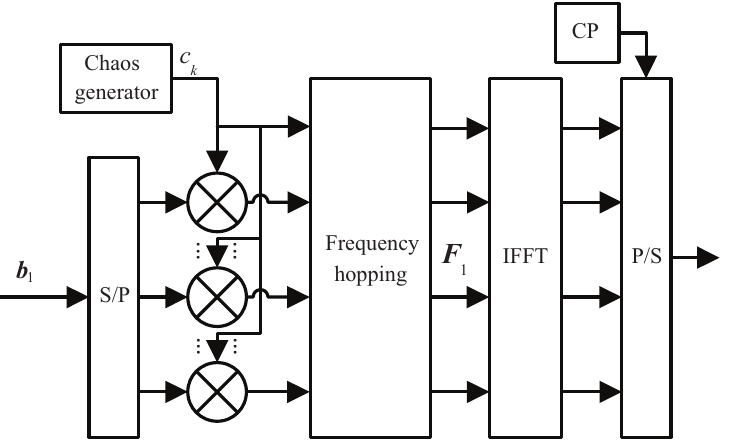
Figure 2. Structure of the FH-OFDM-DCSK transmitter with the antenna